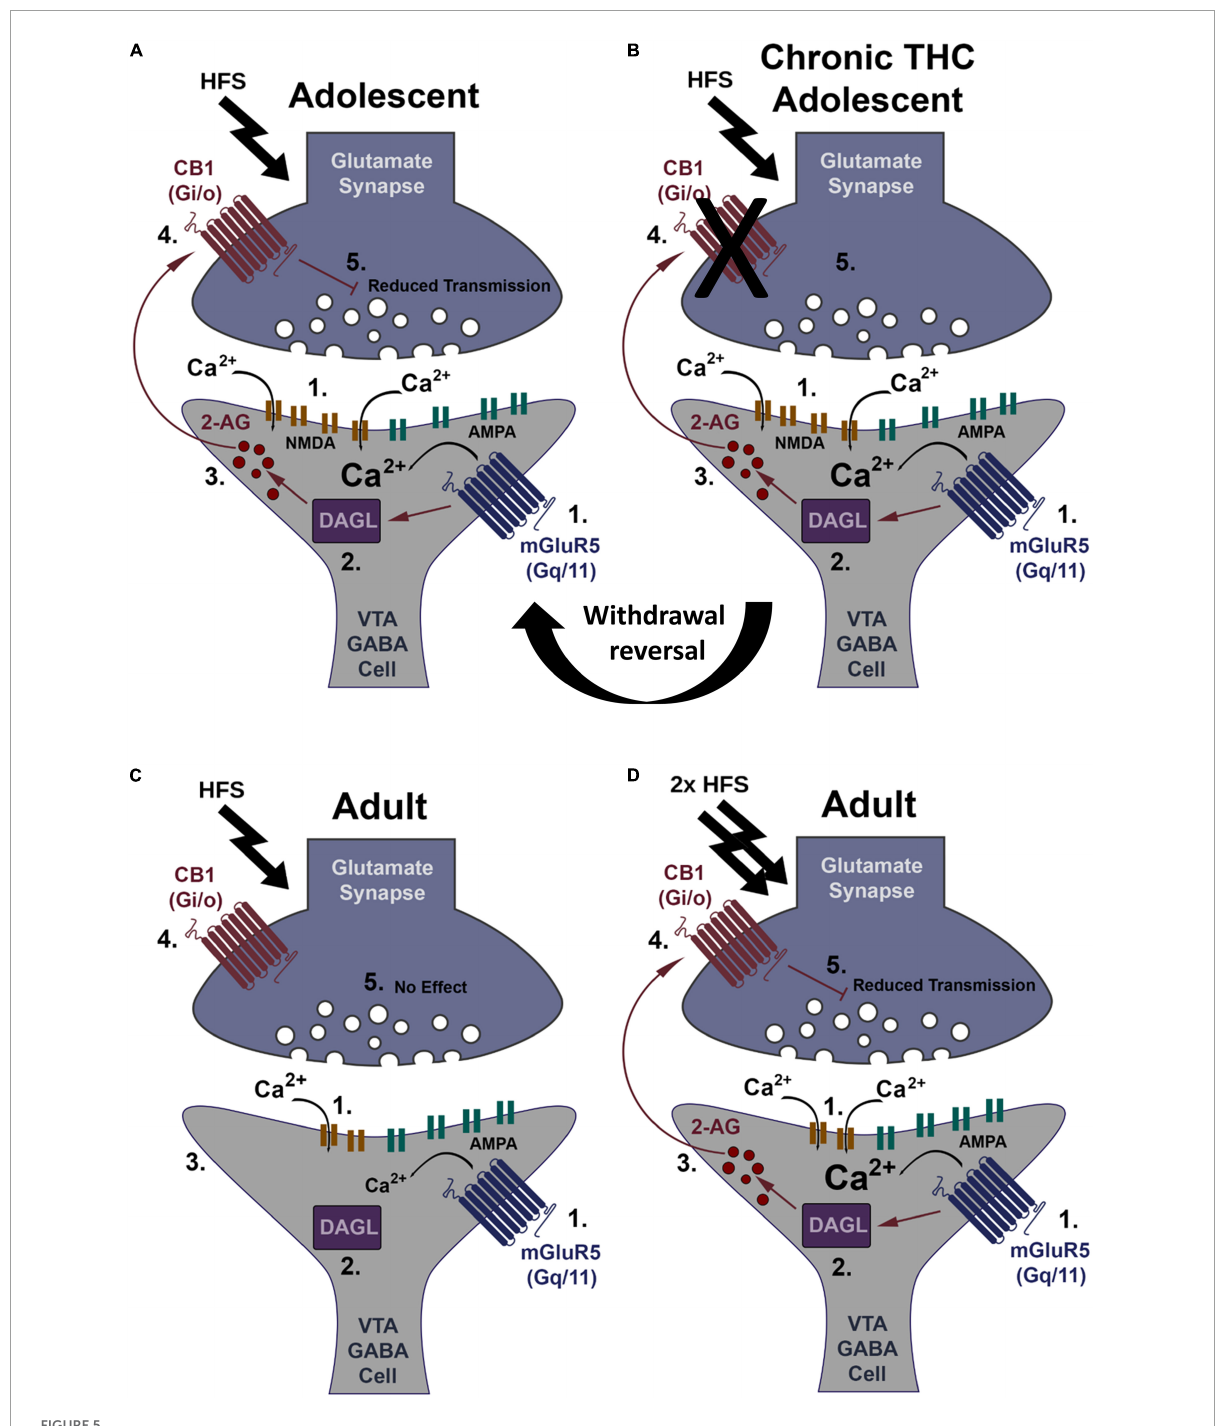
FIGURE5 Working model of CB1-dependent LTD of VTA GABA neurons and increased induction thresholds in adults. (A) HFS (2 × 100 Hz) within young mice causes glutamate release sufficient to activate both mGluR5 and NMDA receptors, causing Ca 2 + influx (1). Ca 2 + activates DAGL α (2), creating the retrograde signaling endocannabinoid, 2-AG (3). 2-AG leaves the postsynaptic neuron and binds presynaptic CB1 receptors (4). CB1 activation depresses glutamate transmission resulting in LTD (5). (B) HFS within young mice chronically exposed to THC does not induce LTD. This loss of LTD is potentially at the CB1 receptor through internalization following constitutive activation by THC or impediments to its signal cascade. Following withdrawal this synapse reverses back to plasticity induction capacity similar to THC naïve (see “Withdrawal reversal”). (C) Within adults, HFS is not strong enough to induced LTD, likely due to a potential decrease in NMDA receptor levels reducing Ca 2 + influx (1). Lower Ca 2 + levels are insufficient to activate DAGL α (2). No 2-AG is produced (3), CB1 is not activated (4), and there is no LTD (5). (D) Double HFS within adults causes glutamate release sufficient to activate both mGluR5 and NMDA receptors more intensely, causing increased Ca 2 + influx (1). Ca 2 + activates DAGL α (2), creating the retrograde signaling endocannabinoid, 2-AG (3) that binds the CB1 receptor (4) to induce LTD